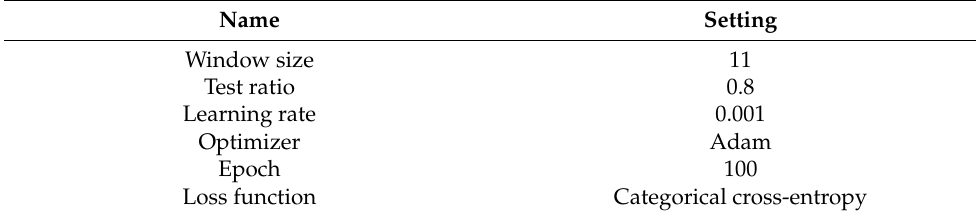
Table 3. Configuration of the network